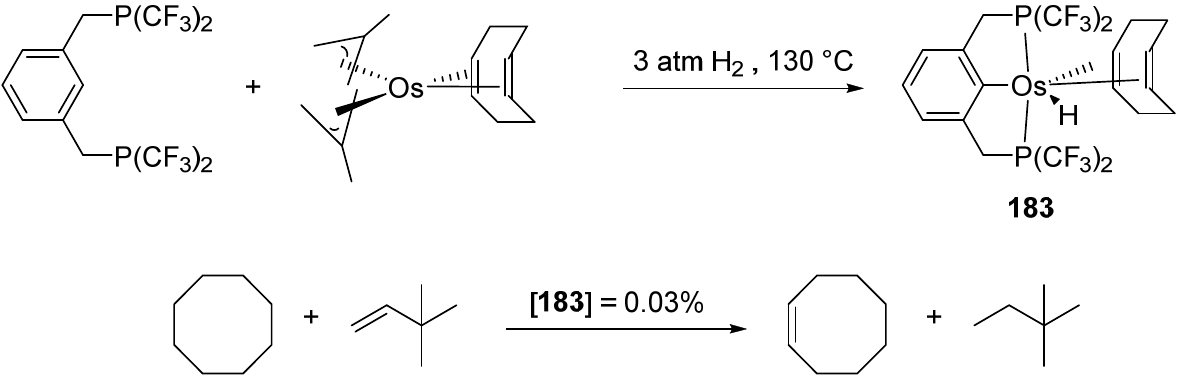
Figure 41. Alkane dehydrogenation catalyzed by a fluorinated P~C~P pincer complex. Esteruelas’ group reported on the metalation of imidazolium salts using [OsH 6 (P i Pr 3 ) 2 ]. Stable compounds 185 and 187 , like possible intermediates in catalytic hydrogenation, were isolated (with yields from 83 to 89%) through the osmium reduction in the presence of HBF 4 . The authors also explored the substitution of the η 2 -bonded molecular hydrogen by a coordinating molecule like acetonitrile [100]. The metalation of 1-(2-methoxy-2-oxoethyl)-3-methylimidazolium chloride afforded cyclometalated acyl complex 188 which coordinates dioxygen, dihydrogen, and carbon monoxide (Figure 42). Complex 188 was used as a catalyst for alcoholysis and hydroly- sis of pinacolborane. Using a 2% mol catalyst charge for the alcoholysis reaction, TOFs between 62 and 3644 h − 1 were obtained at 50% conversion. For the hydrolysis carried out with the same amount of catalyst, TOFs were 473–1648 h − 1 at 50% [101]. The 2- (aminomethyl)pyridine-based complexes 190 were used in the imine-to-amine hydrogena- tion (Figure 43). Depending on the reaction conditions, conversions between 26 and 99% were observed. In this work, the ruthenium equivalents of 190 were also obtained. In general, under the same reaction conditions, the osmium complexes were found to be less active than the corresponding ruthenium derivatives